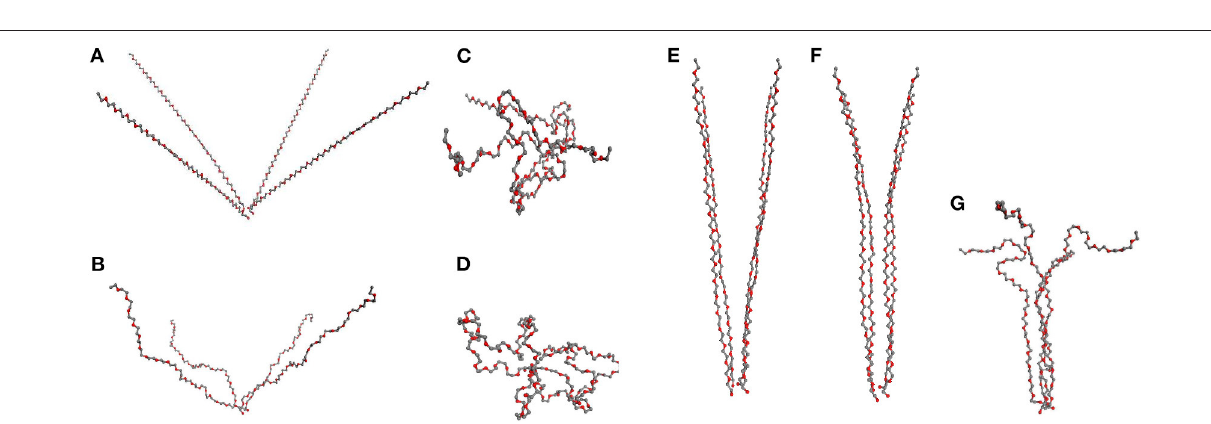
FIGURE 7 | “Four chains model”: (A–D) 4 PEG chains initially at angle 50 ◦ with subsequent relaxation: (A) stretched chains, (B) unstretched chains; (C) loops of type 2, (D) loops type of 1. (E–G) PEG chains initially at angle 10 ◦ , relaxing subsequently to partially aligned stretched chains, (F) , in (G) a fibril after